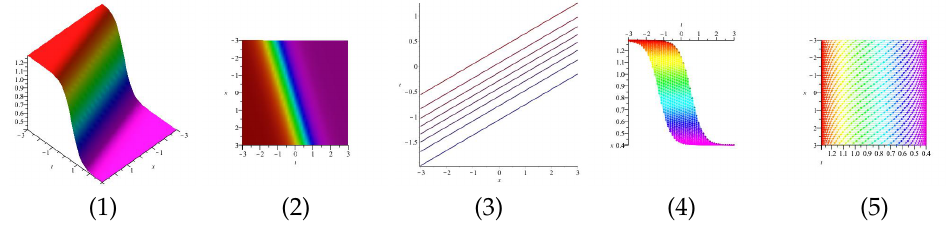
Figure 17. The 3D and 2D with the diagram of equation u (cid:48)